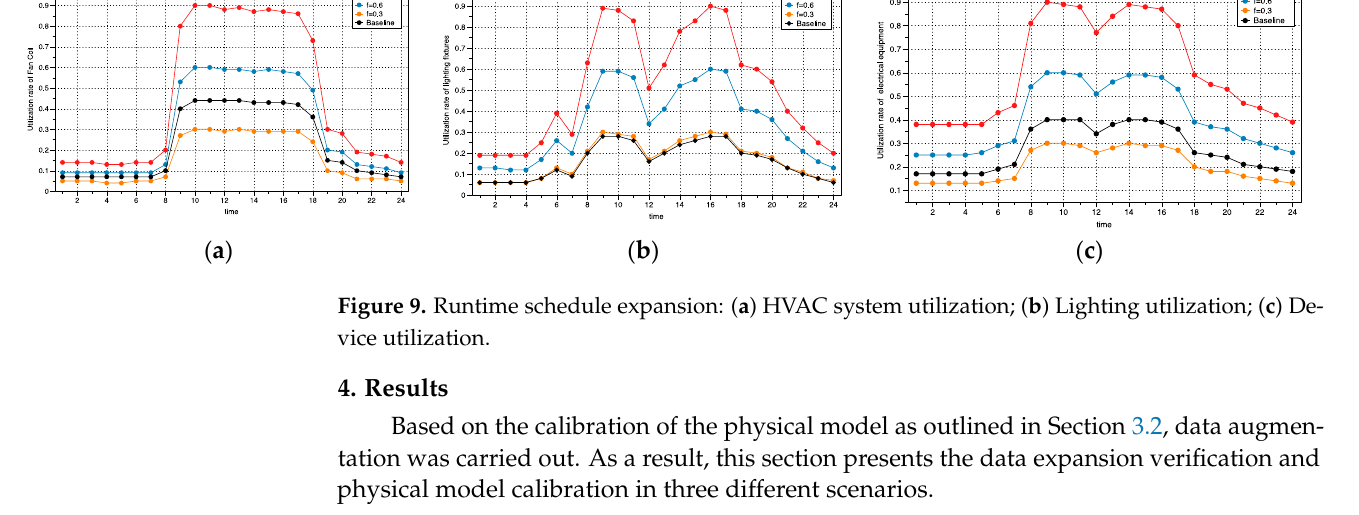
( b ) Figure 8. Chilled water pump efficiency curve: ( a ) Chilled water pump; ( b ) Cooling water pump. Chilled water pump: (cid:1832)(cid:1870)(cid:1832)(cid:1838)(cid:1842) = 0.0596 + 0.1881 × (cid:1842)(cid:1838)(cid:1844) − 0.0136 × (cid:1842)(cid:1842)(cid:1838)(cid:1844) (cid:2870) + 0.2610 × (cid:1842)(cid:1842)(cid:1838)(cid:1844) (cid:2871) (8) Cooling water pump: (cid:1832)(cid:1870)(cid:1832)(cid:1838)(cid:1842) = 0.0069 + 0.1148 × (cid:1842)(cid:1842)(cid:1838)(cid:1844) − 0.1375 × (cid:1842)(cid:1842)(cid:1838)(cid:1844) (cid:2870) + 0.5732 × (cid:1842)(cid:1842)(cid:1838)(cid:1844) (cid:2871) (9) where (cid:1832)(cid:1870)(cid:1832)(cid:1838)(cid:1842) is the ratio of pump input power to rated power. P (cid:1842)(cid:1838)(cid:1844) is the ratio of the pump delivery flow to the rated flow. 3.3. Data Augmentation According to the baseline in Figure 9a–c, the actual operation schedule (utilization